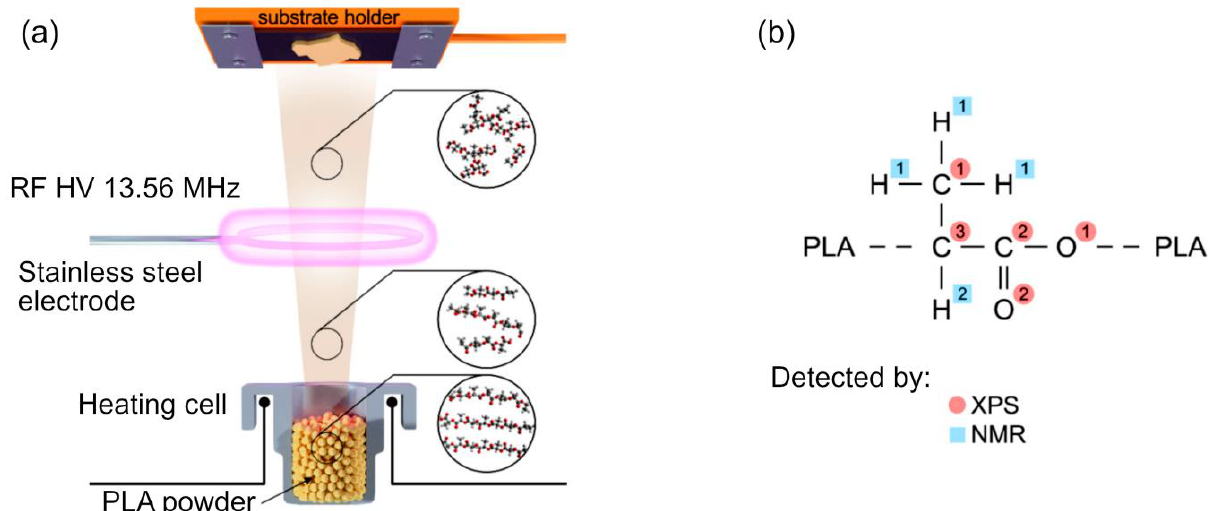
Figure 13. ( a ) Experimental setup used for PAVTD of PLA-like coatings and ( b ) chemical structure of conventional PLA with the assignment of C, O, and H that corresponds to different spectral peaks detectable by XP and NMR, respectively. Reproduced from Krtouš et al. (2021) [94] under conditions of the CC BY license.